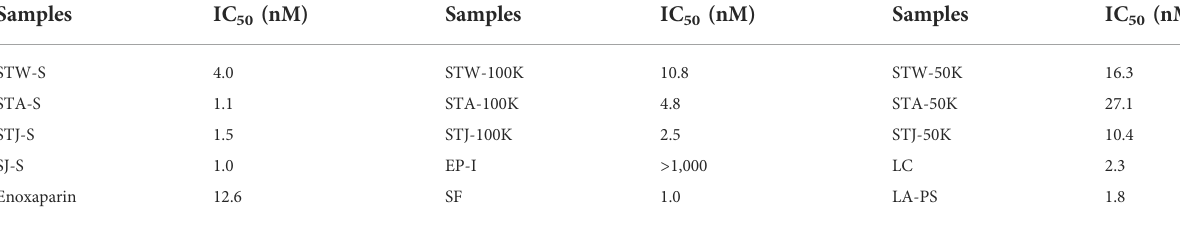
TABLE 3 IC 50 values of sulfated glycans on inhibiting PF4 binding to heparin (on chip surface). Samples IC 50